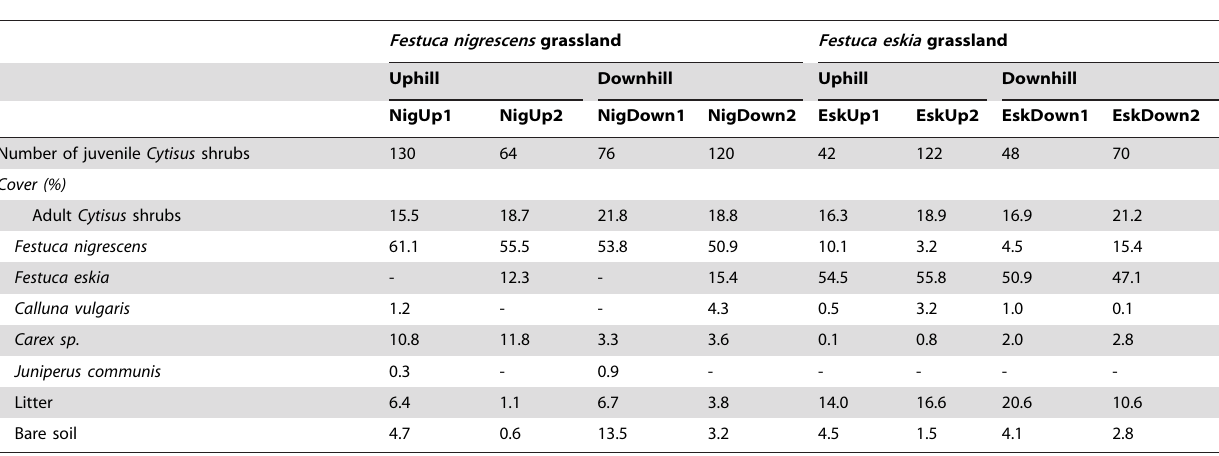
Table 1. Total number of juvenile Cytisus shrubs in each plot and total cover (%) for each cover type (species, bare soil and